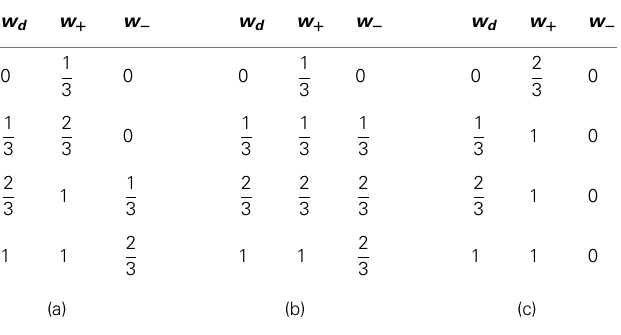
dynamic range ( d = 0%) are highlighted in red.The limit toward low numbers of SSPs ( n = 15 in case of r = 4 bits) is caused by rounding effects (equation 2), whereas the upper limit ( n = 206 in case of r = 4 bits) is caused by too large weight updates. Green dashed lines indicate cross sections shown in (C,D) . (C) Cross section of (B) at a 4-bit weight resolution.The histograms shown in (A) are depicted with arrows. (D) Cross section of (B) at n =